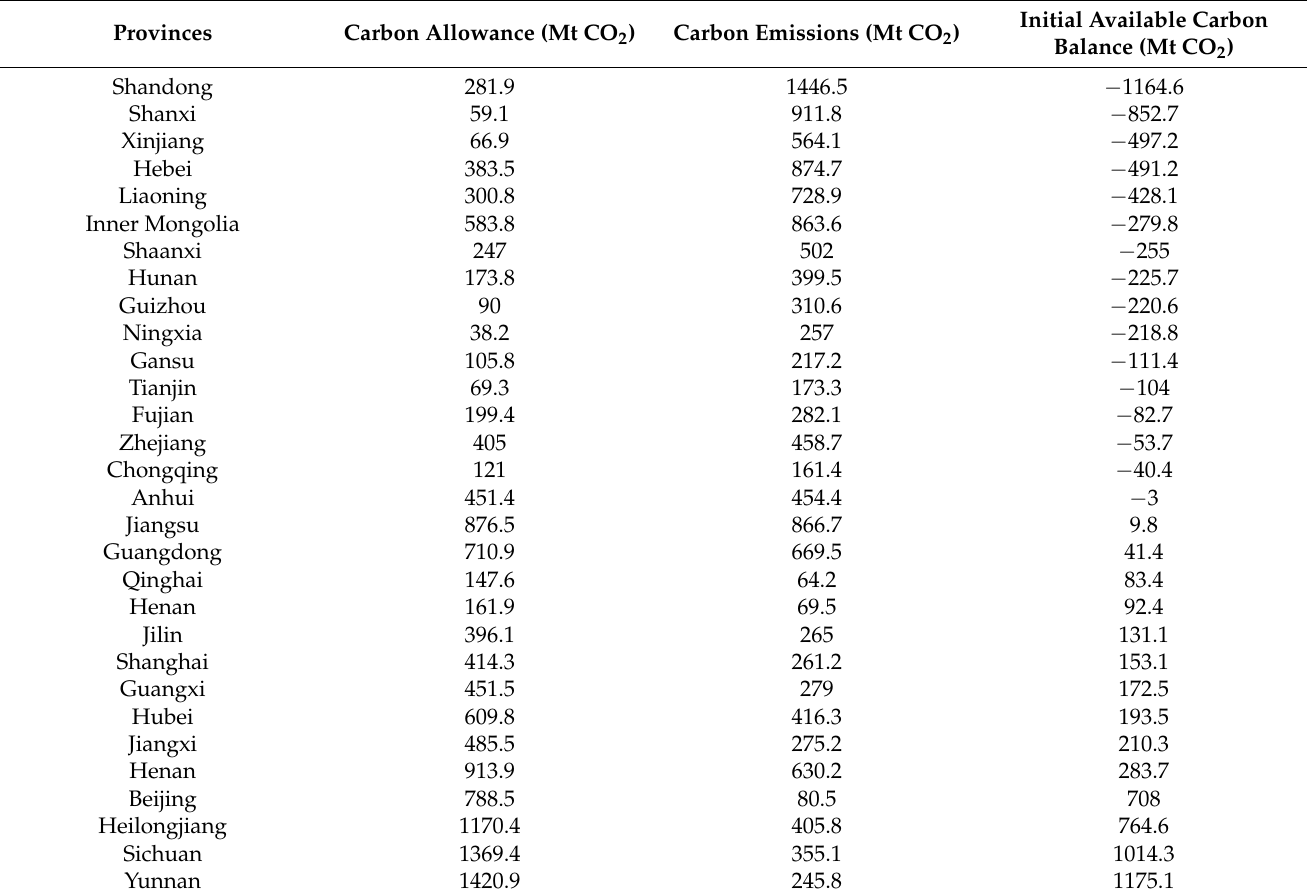
Table 2. Allocation of carbon emission rights by province in China (modified from Tian and Lin